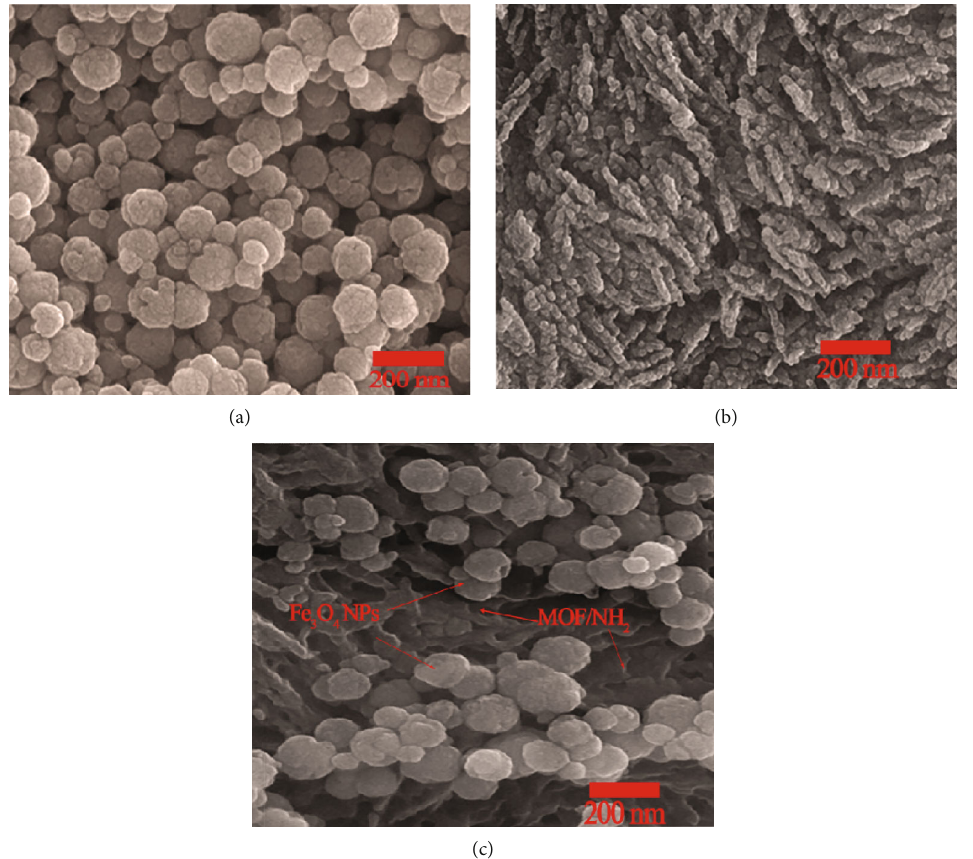
Figure 2: SEM images of Fe